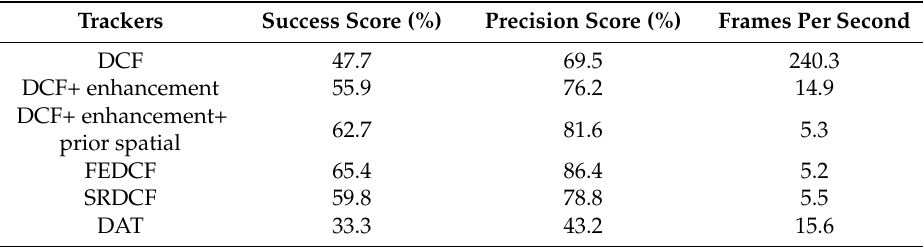
Table 2. The evaluation of OPE in term of scores of success and precision plots on OTB2015. The top score is marked in